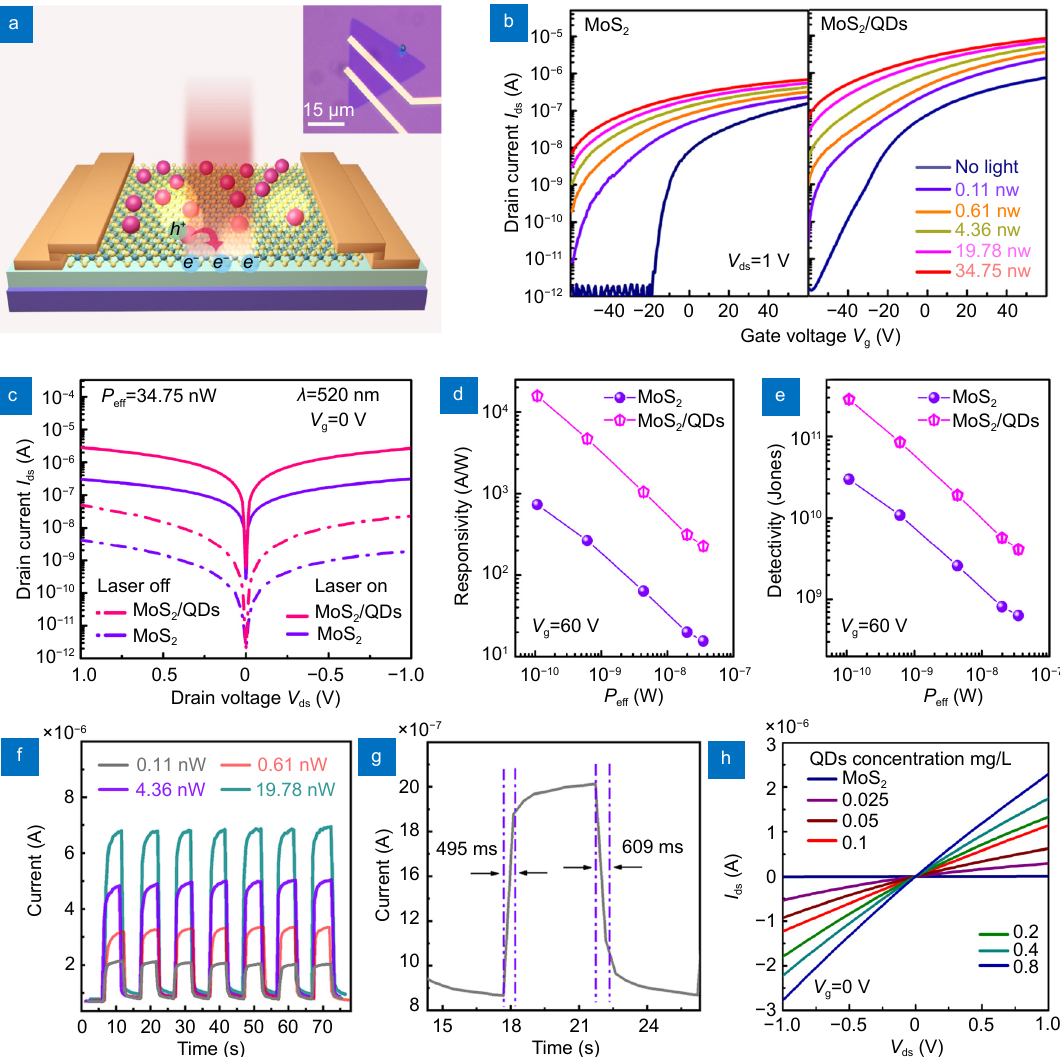
Fig. 5 | Optoelectronic performance of the vdWHs phototransistor compared with a pristine MoS 2 phototransistor. ( a ) Schematic view of the phototransistor device, and the inset is an optical image of the as-prepared device with the scale bar of 10 μm. ( b ) Transfer characteristics of two devices in the dark and under the illuminations (from 0.11 nW to 34.75 nW) at V ds =1 V. ( c ) Transfer characteristics in dark (dotted line) and under the illumination (solid line, P eff = 34.7 nW) at V g =0 V. ( d ) Photoresponsivities and ( e ) specific detectivities of two devices as a function of ef- fective powers at V g =60 V, respectively. ( f ) Time-dependent photoresponses under the pulsed illumination powers (from 0.11 nW to 19.78 nW) over multiple cycles at V ds =1 V. ( g ) The rise and fall times in photocurrent extracted from figure (f) under the illumination of 0.11 nW. ( h ) The pho- tocurrent curves of vdWHs device with various QDs